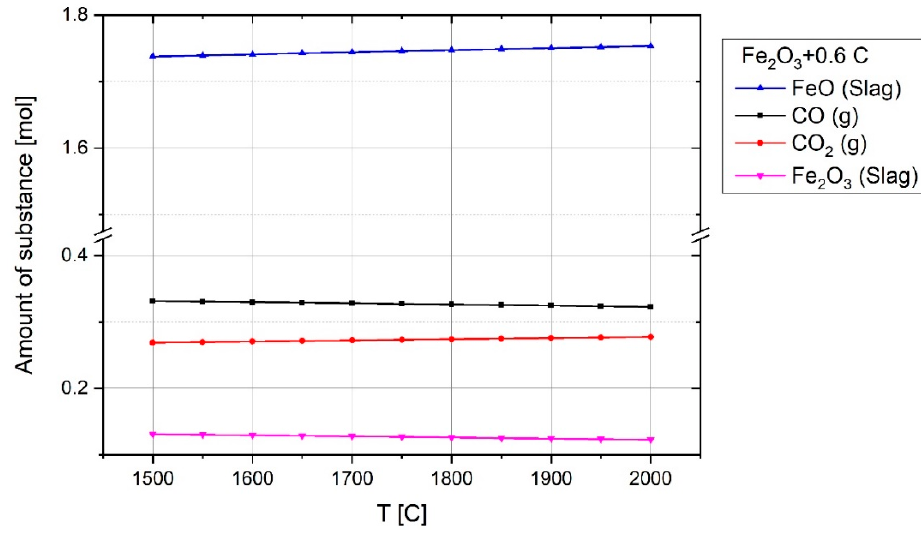
Figure 11. The composition of 0.6 mol of carbon and one mol of haematite at equilibrium over temperature.